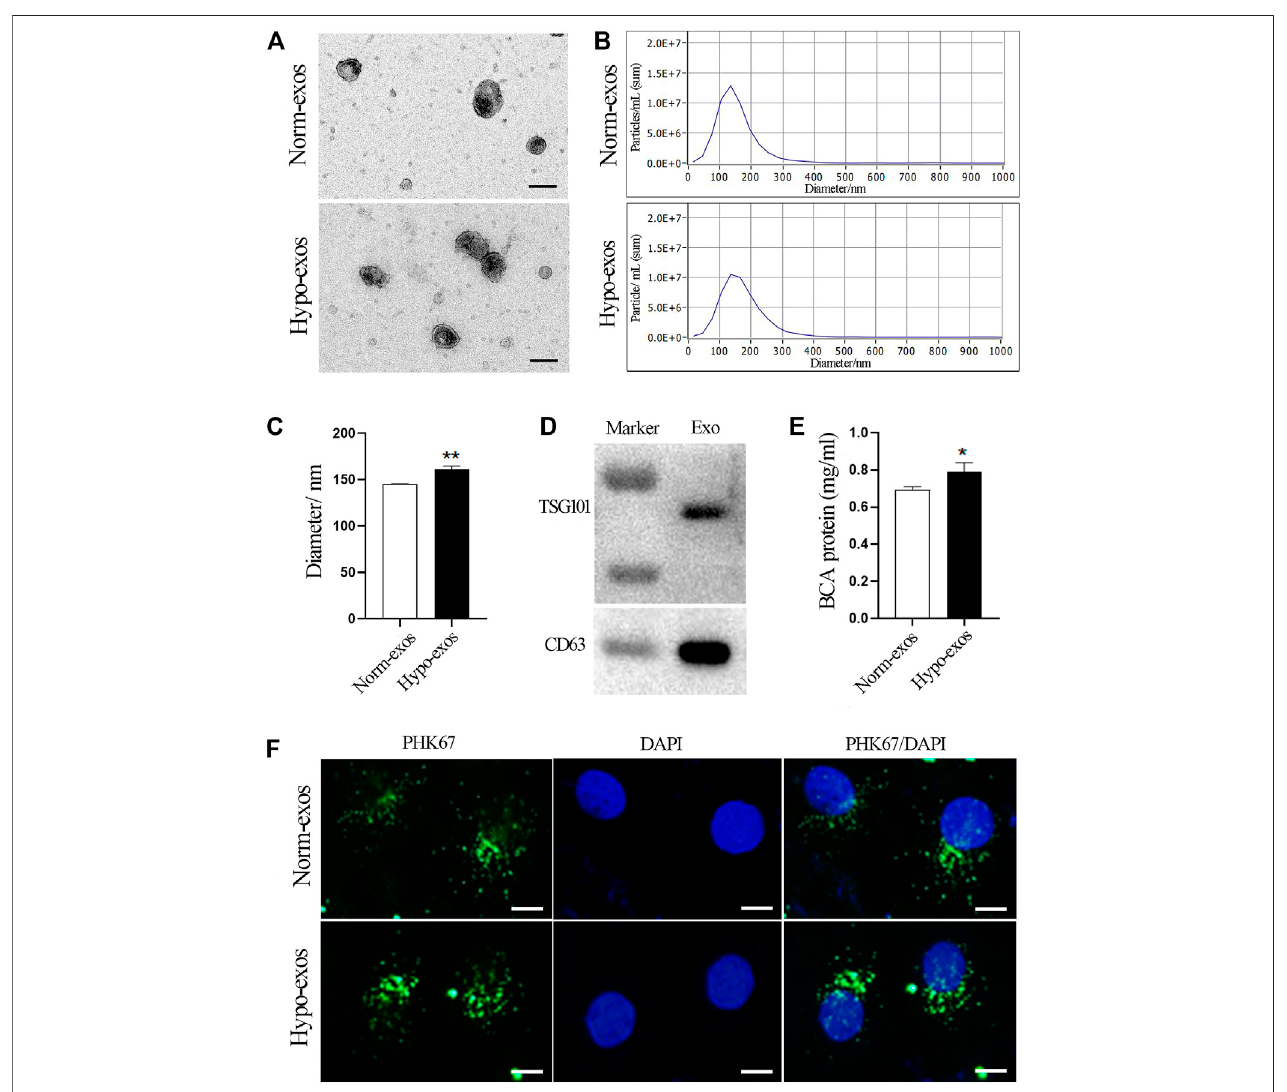
FIGURE 1 | Characterization and internalization of Hypo-exos and Norm-exos. (A) Morphology of Hypo-exos and Norm-exos observed using transmission electron microscopy; scale bars = 100 nm. (B) Particle size distributions of Hypo-exos and Norm-exos were determined by nanoparticle tracking analysis. (C) ComparisonofmeandiametersofHypo-exosandNorm-exos. (D) ExpressionofCD63andTSG101inexosomesvalidatedusingwesternblotting. (E) Exosomalprotein concentrations in Hypo-exos and Norm-exos analyzed using the BCA assay. (F) Uptake ofPKH67-labeled Hypo-exos and Norm-exos into HUVECs; scale bars = 200 μ m * p < 0.05, ** p <